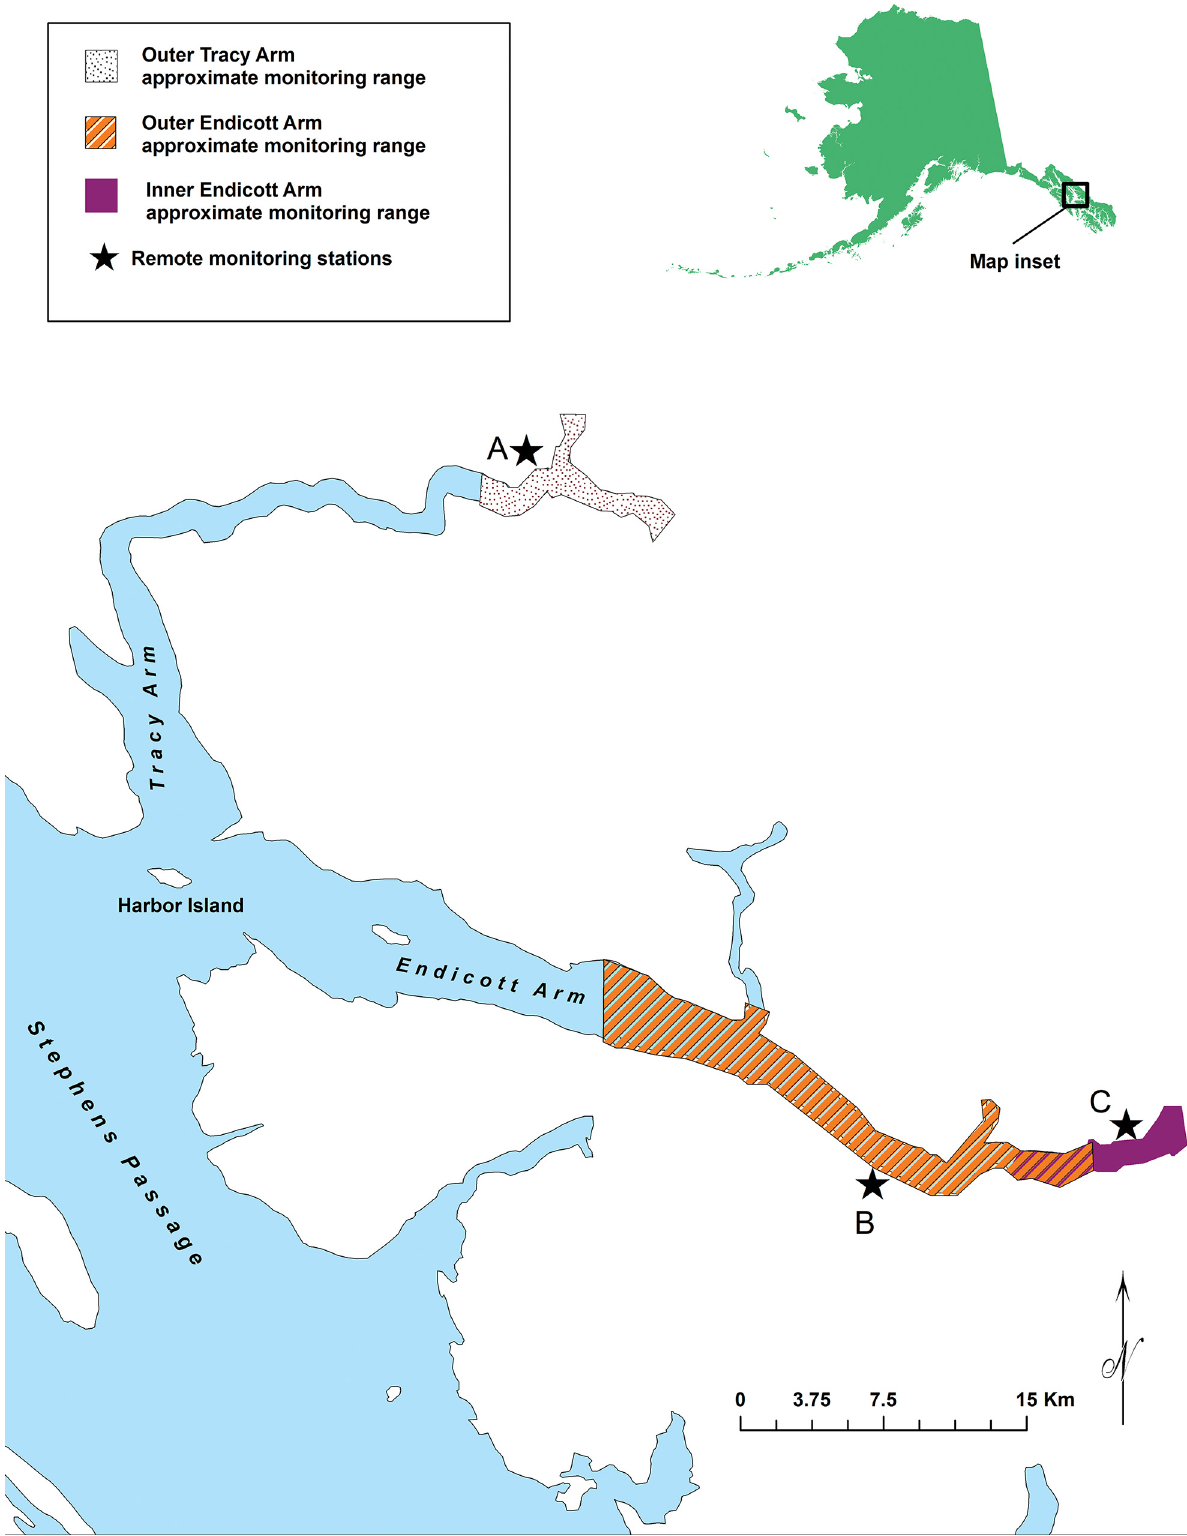
Fig 1. Location of the study area and three remote monitoring sites (stars). Each station was equipped with time-lapse cameras and VHF-telemetry data loggers. Shaded areas indicate the reception ranges at which the data loggers could detect a signal from a transmitting VHF radio tag.